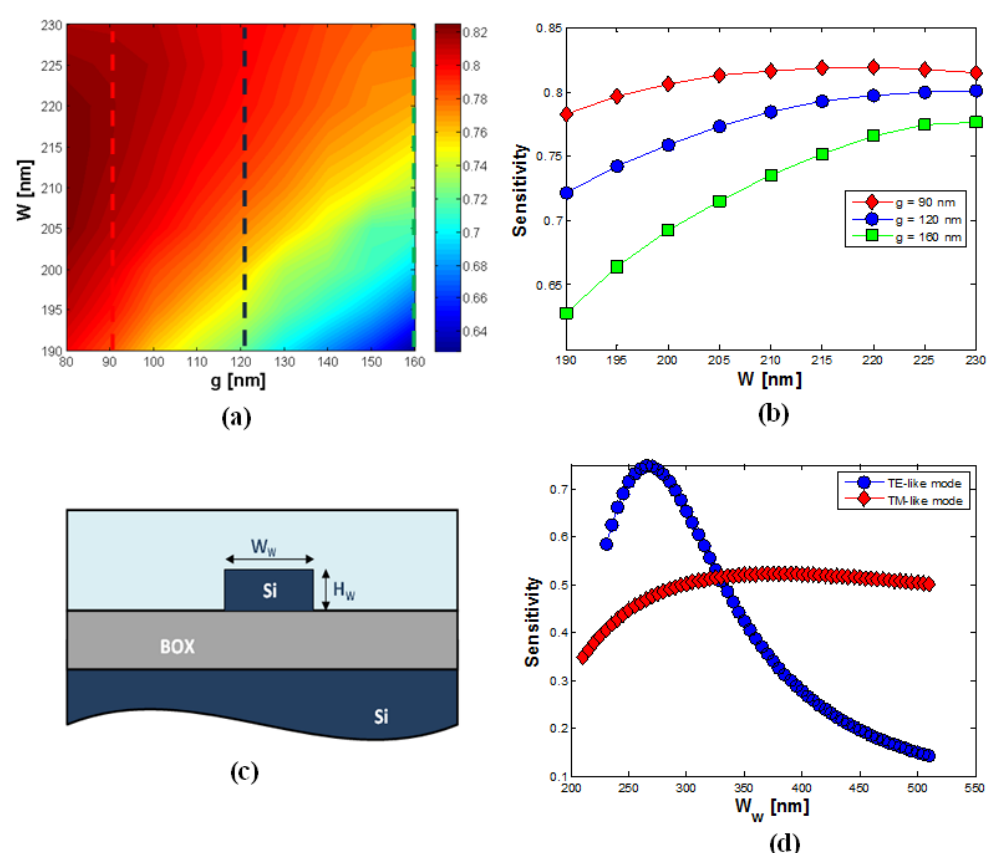
Figure 5. ( a ) Sensitivity versus W and g with H = 220 nm; ( b ) Sensitivity versus W for different values of gap region width; ( c ) Wire waveguide cross section; ( d ) Sensitivity of for a silicon wire waveguide with H = 220 TE-like and TM-like modes versus W w w